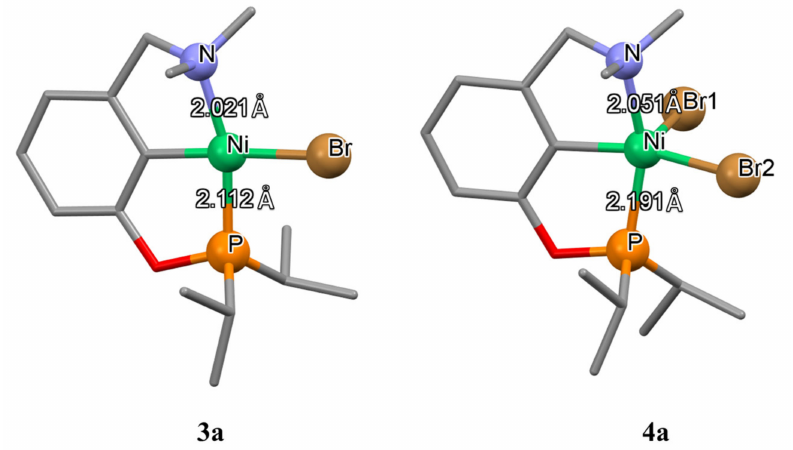
Scheme 3. Synthesis of unsymmetrical POCN pincer nickel complexes 3a – 3c and 4a – 4c [78–81].